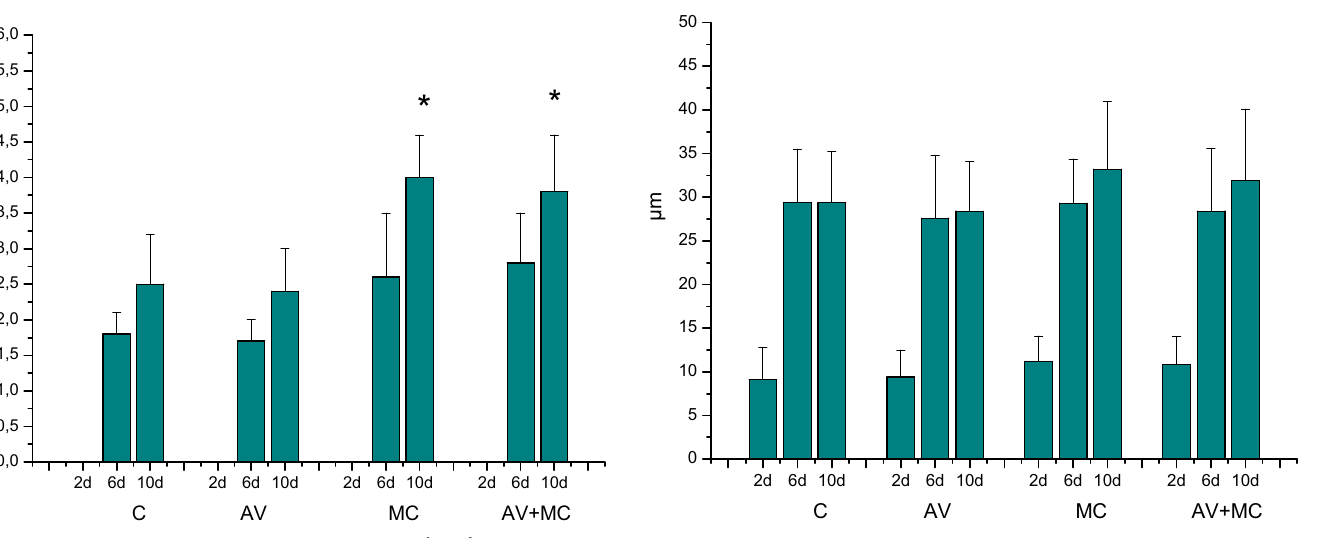
FIGURE 5 – Number of new vessels detected by 10 3 µm 2 of healing area in the region of the skin wound experimentally induced in normal 120-day-old Wistar rats after 2, 6 and 10 days of treatment. C: control; AV: animals topically treated with Aloe vera ; MC: animals treated with microcurrent (10 µA/2 min); AV+MC: animals receiving topical application of Aloe vera plus microcurrent (10 µA/2 min). Values are reported as means ±SD. * represent p<0,05.